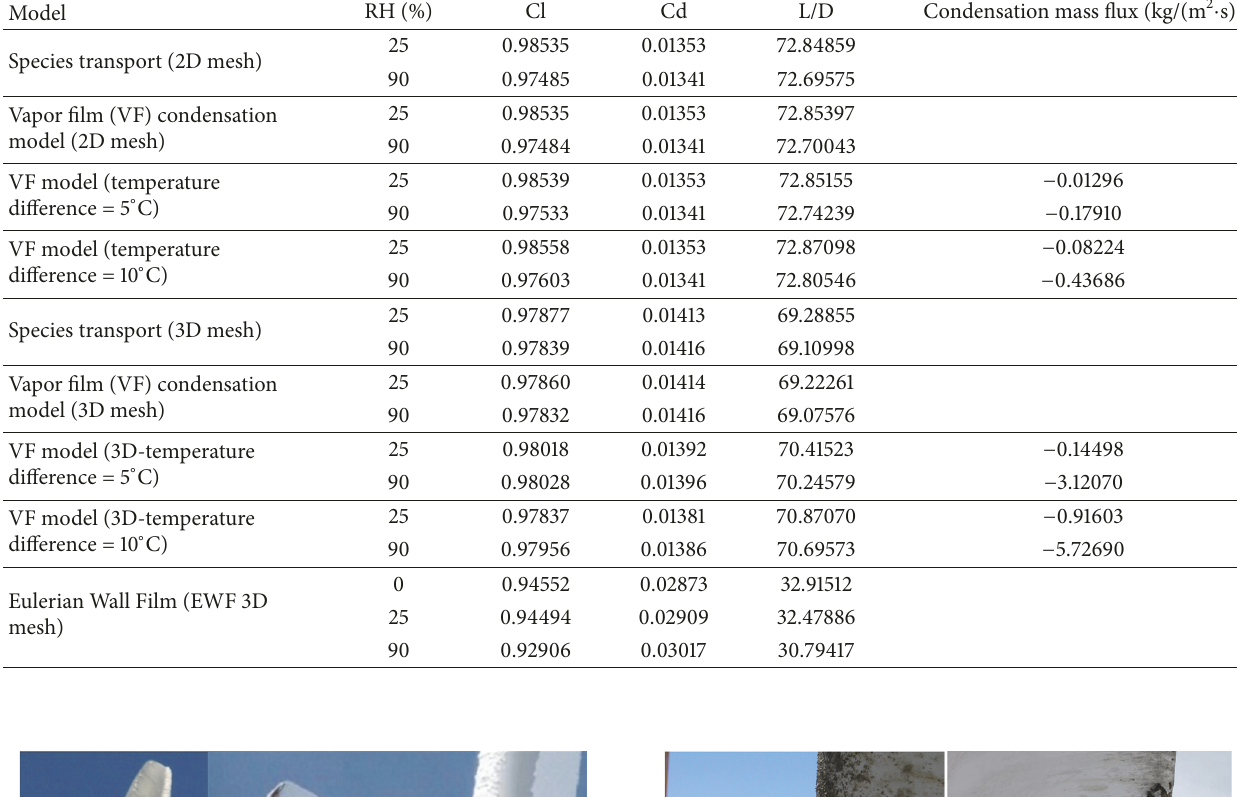
Table 3: Airfoil performance with various condensation models for Re = 3 × 10 6 , AOA = 6 degrees.